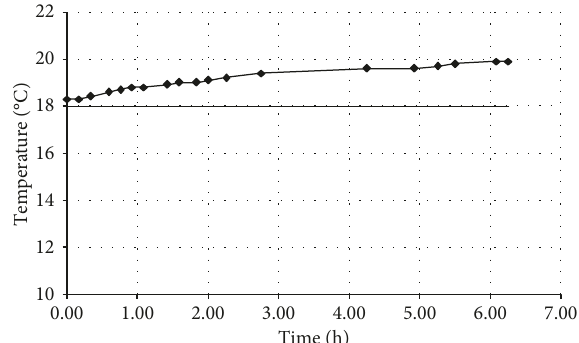
Figure 9: MP paste temperature measurement.